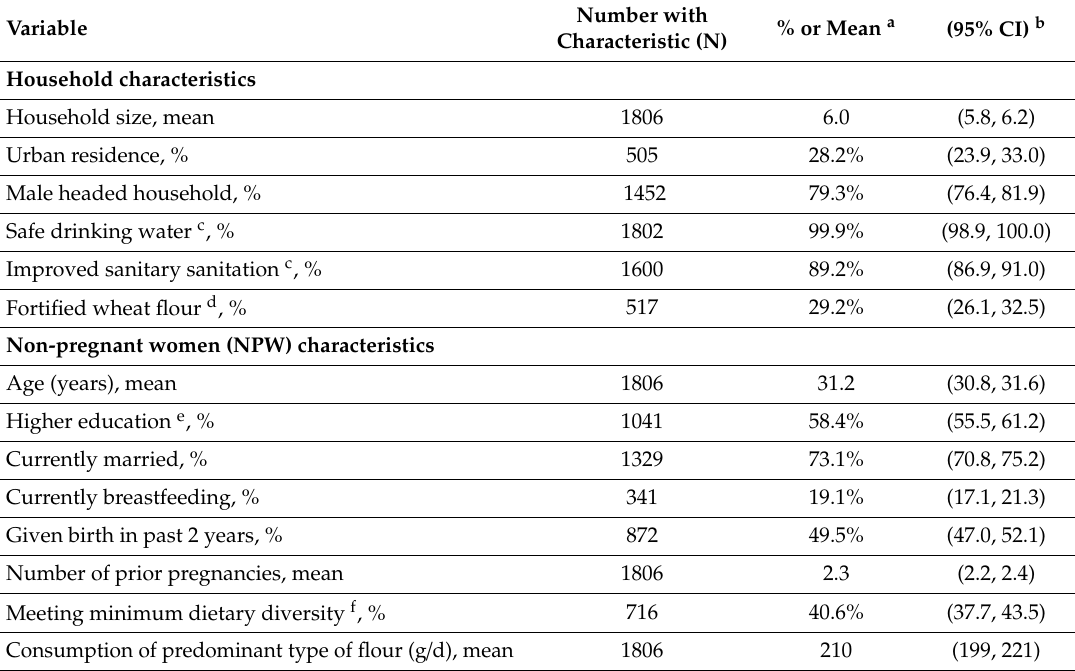
Table 1. Household and demographic characteristics of respondents, Uzbekistan 2017.